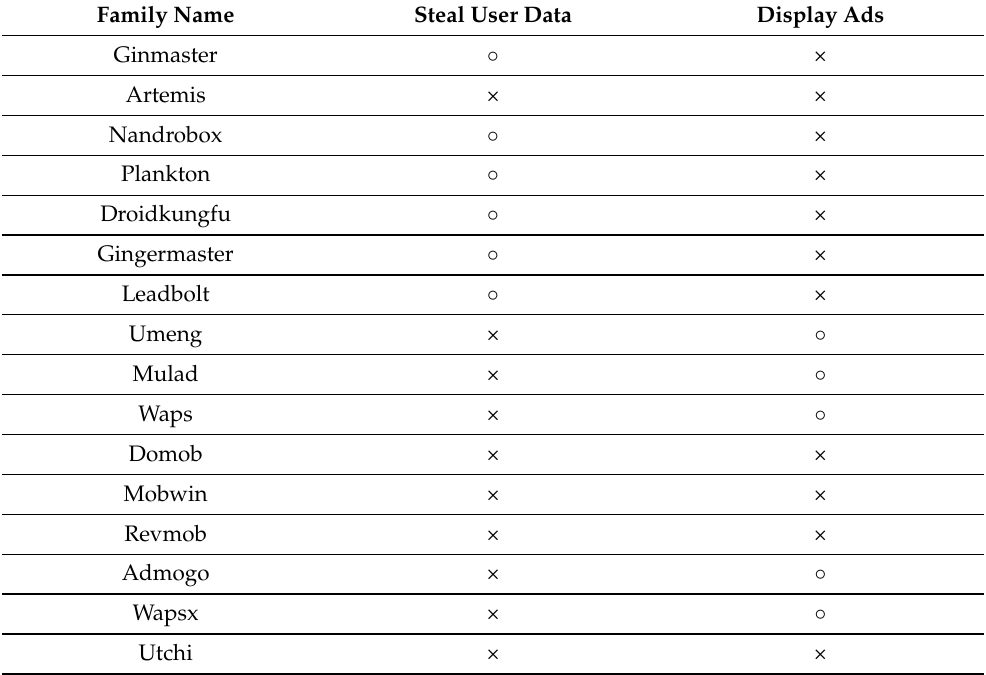
Table 10. The characteristic of the malware families. The malware with the characteristics of stealing user data or displaying advertisements are labeled as ‘ ◦ ’ and those without these characteristics are labeled as ‘×’. Family Name Steal User